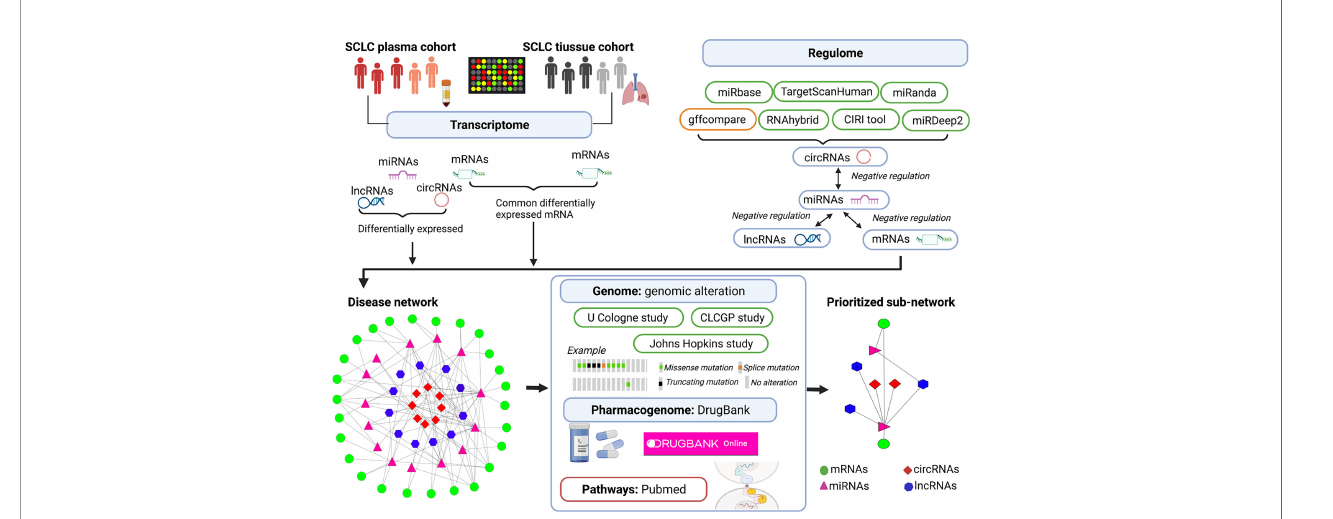
FIGURE 1 | Illustration of multi-omics – based prioritisation of ceRNAs and pathways. CLCGP, Clinical Lung Cancer Genome Project; CIRI, circRNA identi fi er; ceRNA, competitive endogenous RNA; circRNA, circular RNAs; DE, differentially expressed; SCLC, small cell lung cancer; lncRNA, long noncoding RNA; miRNA, microRNA; mRNA, messenger RNA; cBioPortal database (https://www.cbioportal.org/datasets); DrugBank database (https://go.drugbank.com/); Genecards database (https:// www.genecards.org/); PubMed